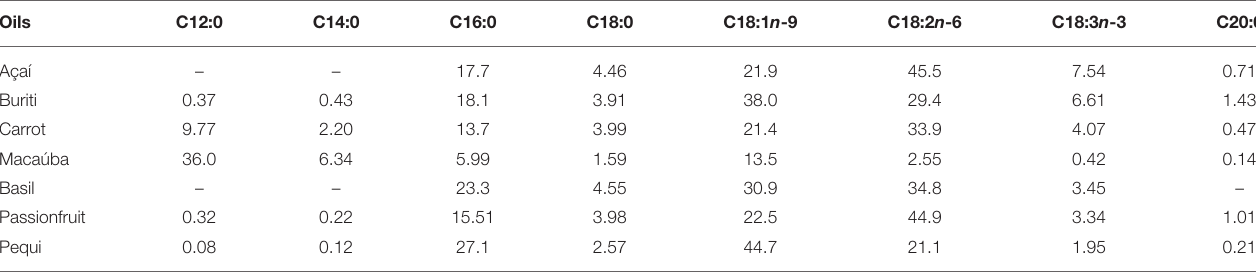
TABLE 1 | Concentration of fatty acids (g/100g of total fatty acids) identified in the oils used in in vitro batch cultures. Oils